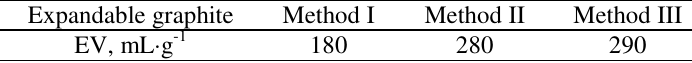
Table 2. Results of orthogonal experiment L